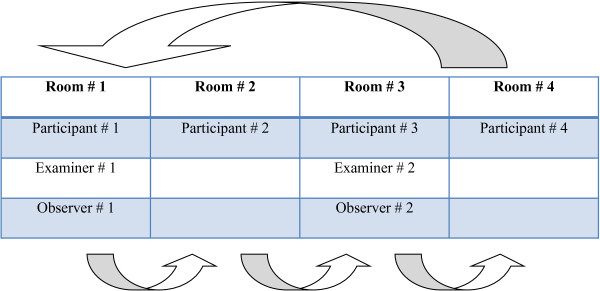
Data collection procedures.